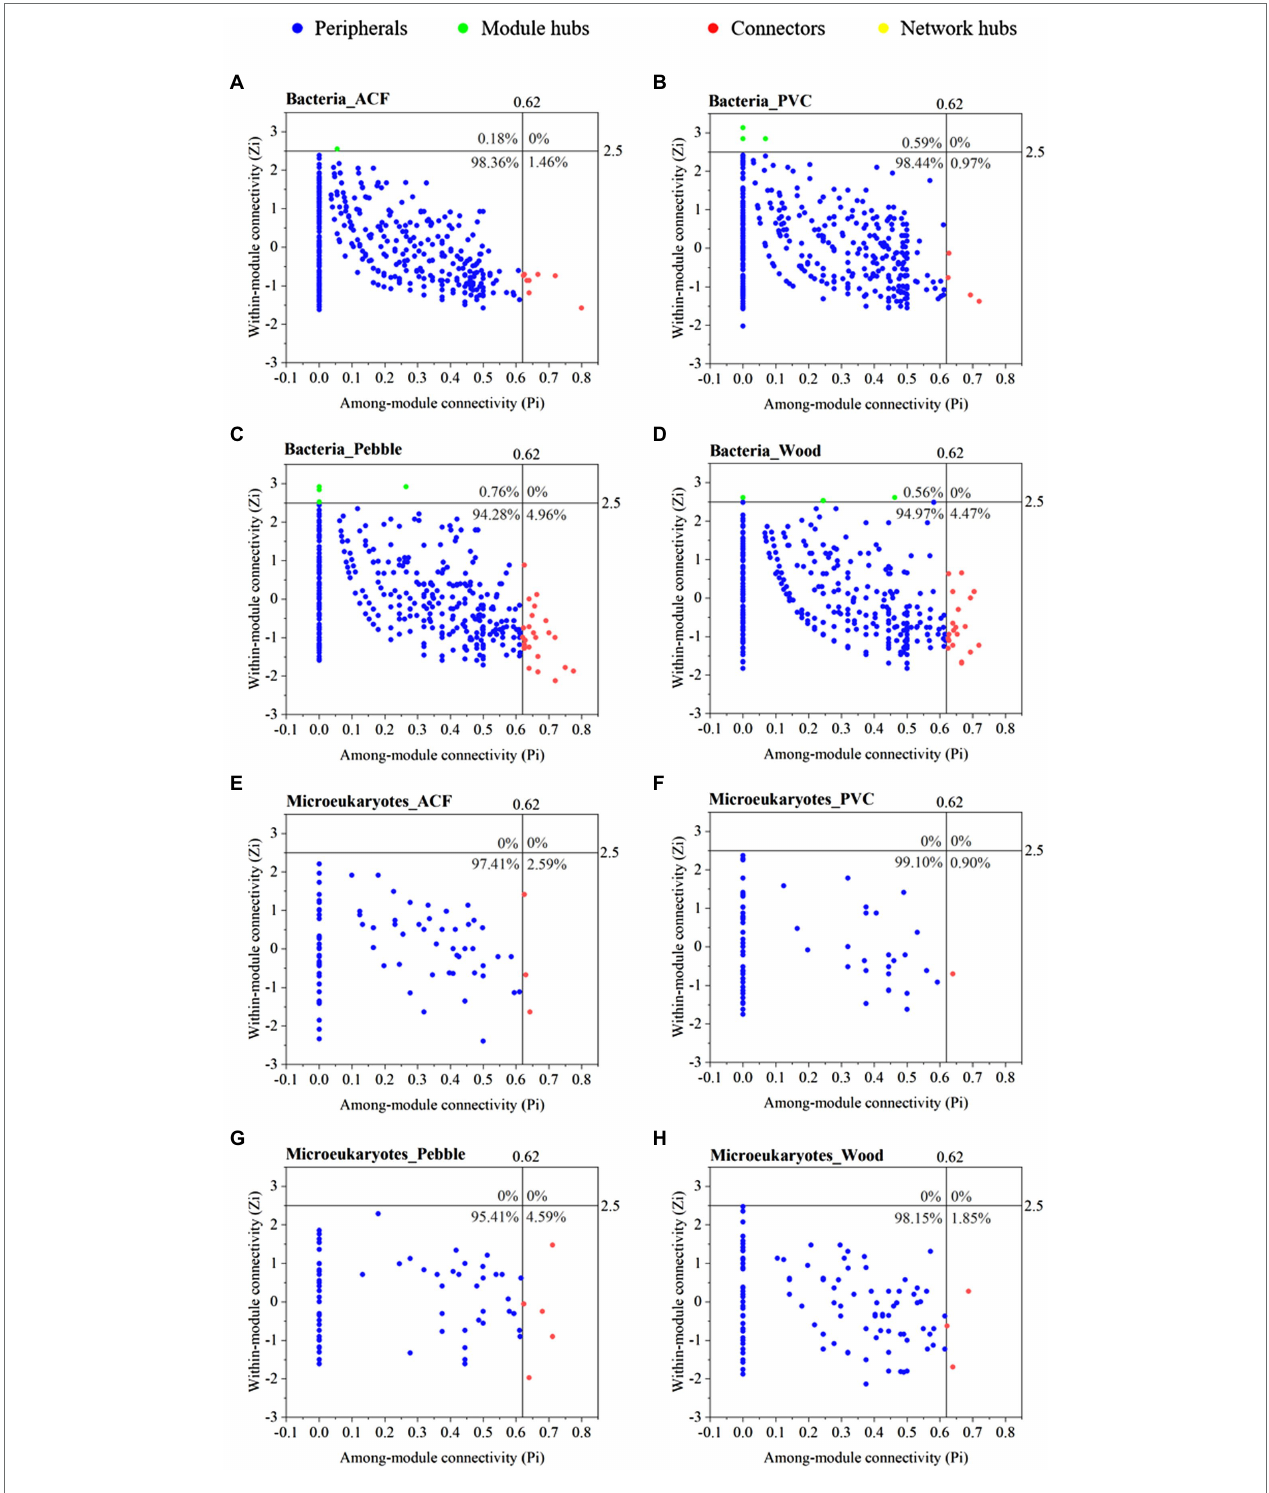
FIGURE 4 | Zi-Pi plot of bacteria (A – D) and microeukaryotes (E – H) at OTU level for the biofilm samples colonised on artificial (ACF and PVC) and natural (pebble and wood) substrates. The topological role of each OTU was determined according to the scatter plot of within-module connectivity (Zi) and among-module connectivity (Pi). Connectors, network hubs, and module hubs were selected as keystone species, and the annotation information of keystone species was shown in Supplementary Table S12